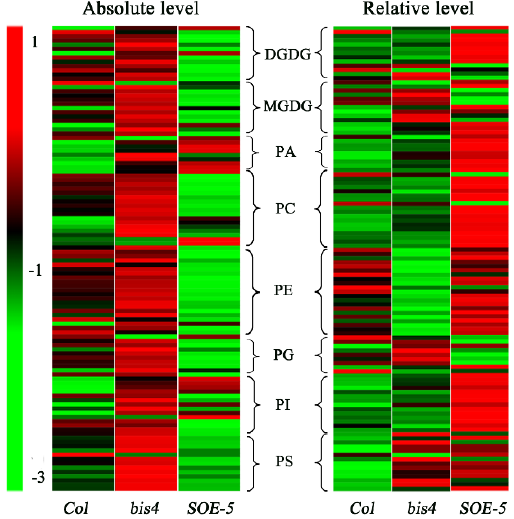
Figure 3. Heat map of lipid molecular species in Col , bis4, and SOE-5 plants. Each color bar in the column represents lipid molecular species in the indicated plant. The color of each bar represents the relative change from the median of each lipid species ( n = 5).